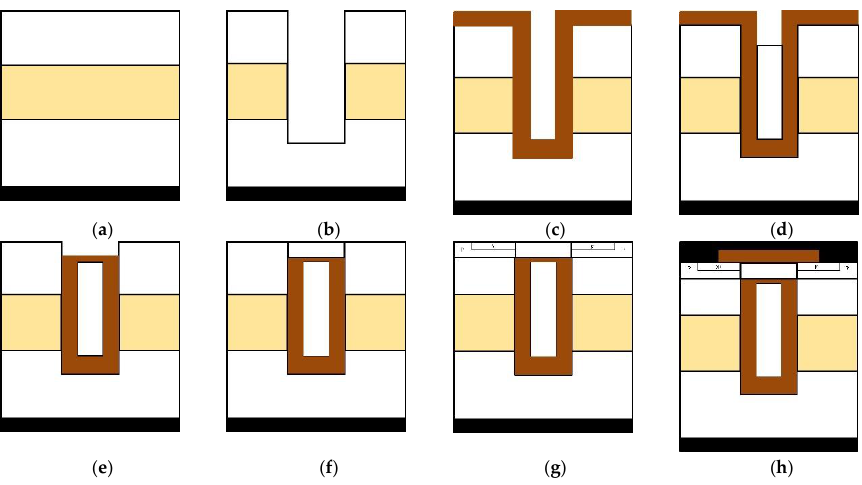
Figure 4. Fabrication procedure of the HDSGRSO UMOSFET.( a ) Epitaxial layers are formed, ( b ) Trench is opened, ( c ) Thick oxide is deposited, ( d ) Polysilicon is deposited and etched back, ( e ) Thick oxide is deposited and etched back, ( f ) Gate oxide and gate poly are formed, ( g ) The p-body and n+ source region are formed, ( h ) Thick oxide and source metal are deposited.